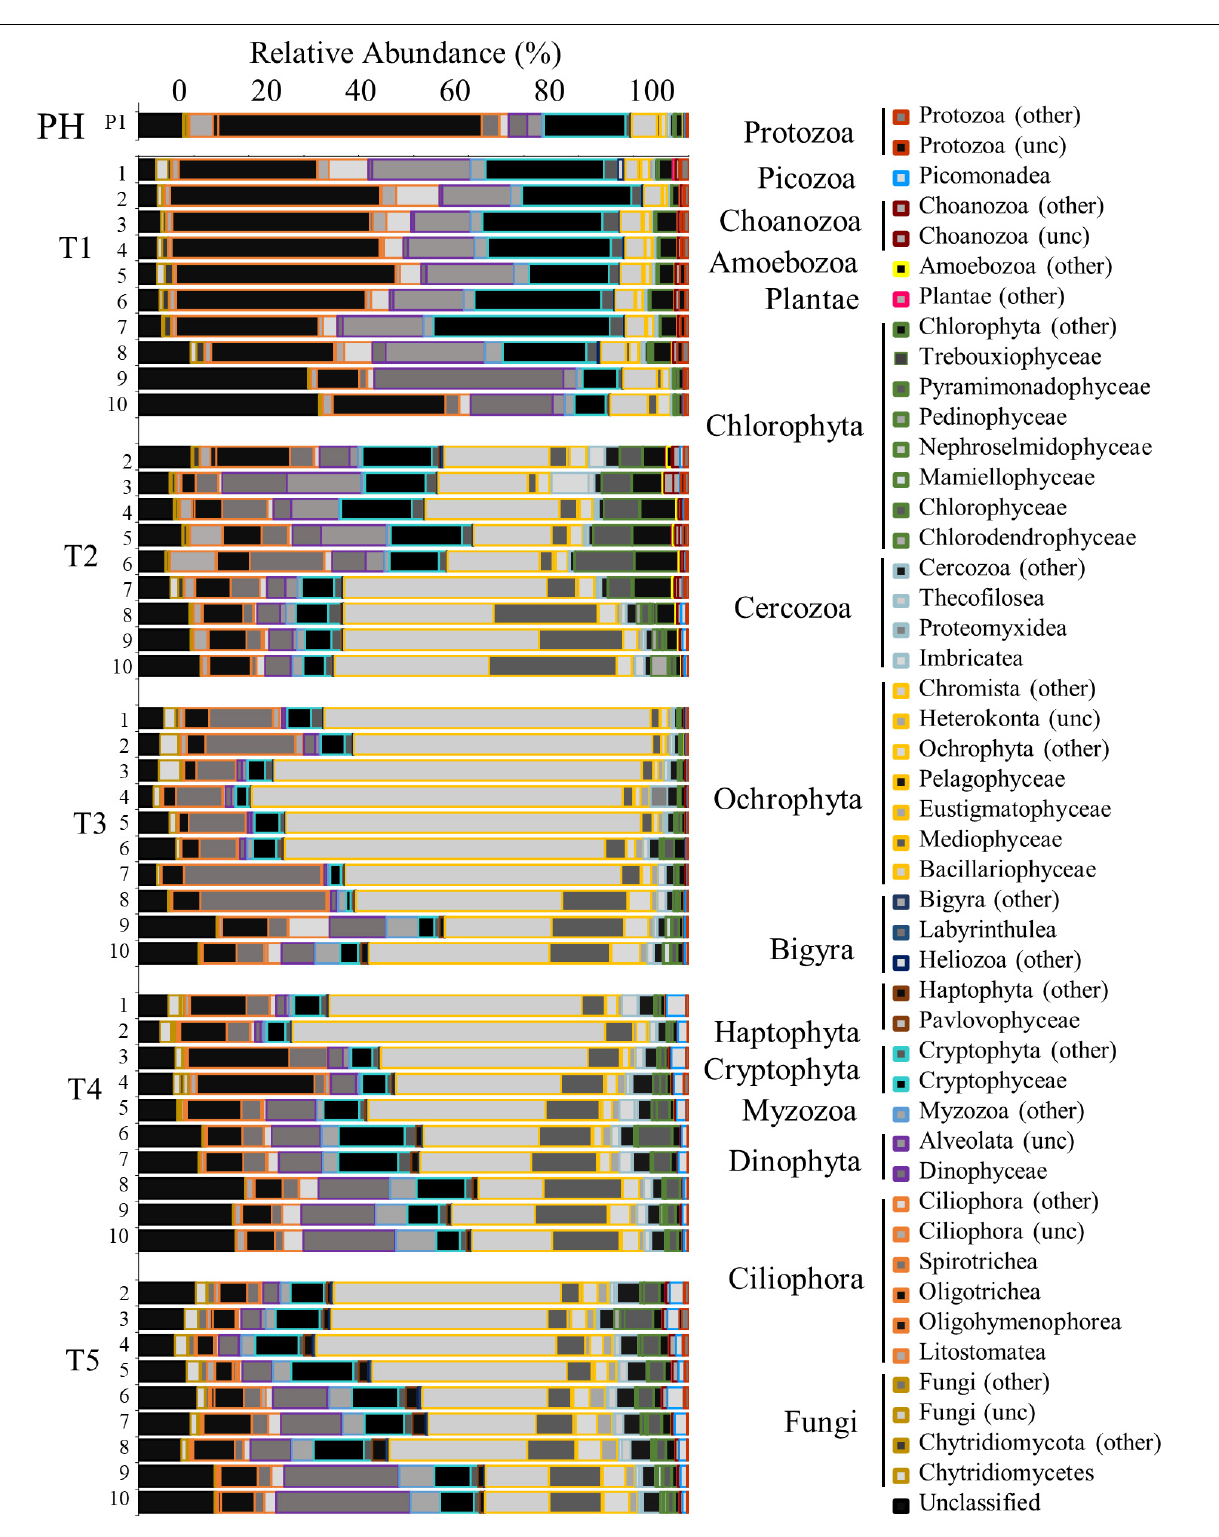
Frontiers in Marine Science |